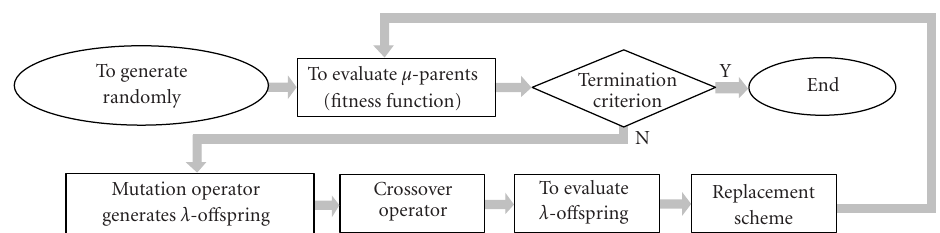
Figure 5: General outline of an evolution